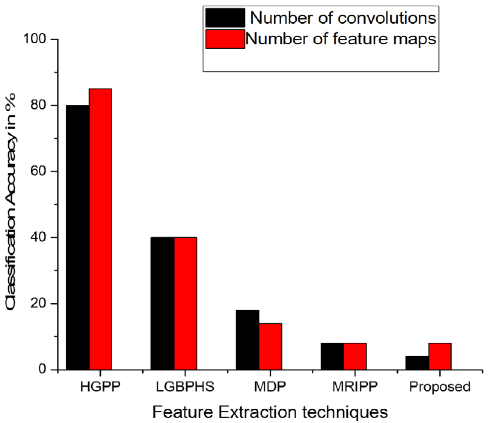
Figure 11. Comparison of complexities with the other multiscale and rotation-invariant feature ex- traction methods.